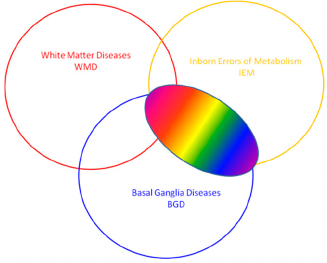
Figure 5. Focus of the review—neuroimaging of basal ganglia in neurometabolic diseases in children—involvement of basal ganglia in inborn diseases of metabolism, often with white matter involvement (three spectra of